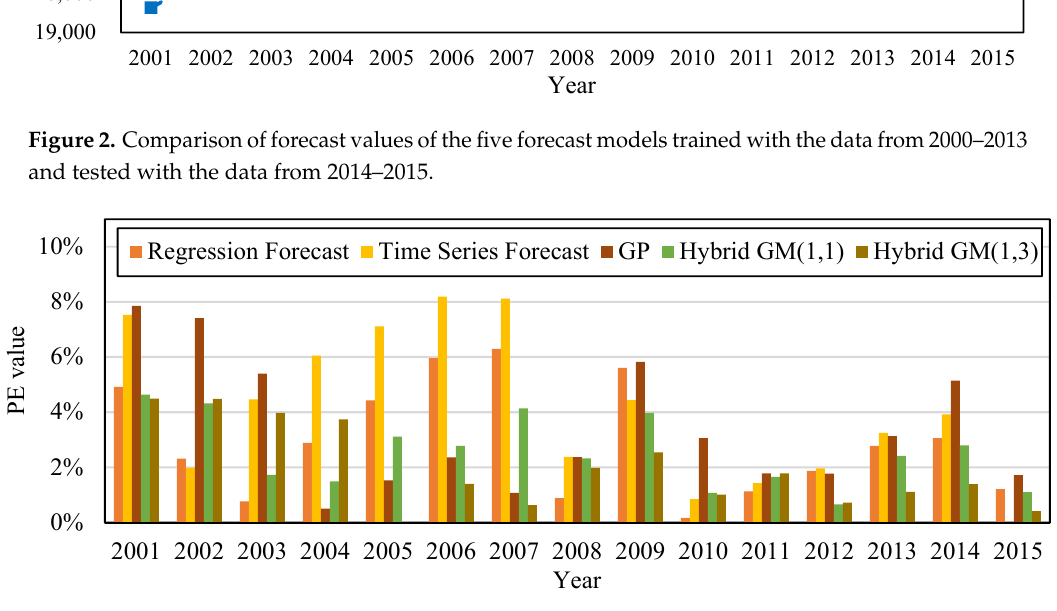
Figure 3. Comparison of PE values of the five forecast models trained with the data from 2000–2013 and tested with the data from 2014–2015.